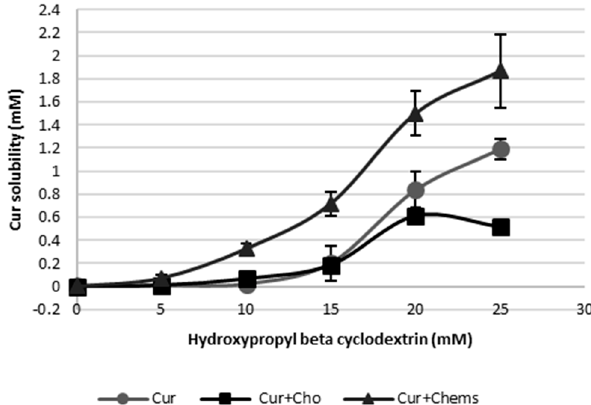
Figure 5. Solubility phase profiles of curcumin (Cur)–hydroxypropyl- β -cyclodextrin (HP β CD), alone and in the presence of cholesterol (Cho) or cholesteryl hemisuccinate (Chems). Equation (1) indicates that the plot of log( S tot - S 0 ) versus log [CD] should be a linear curve with